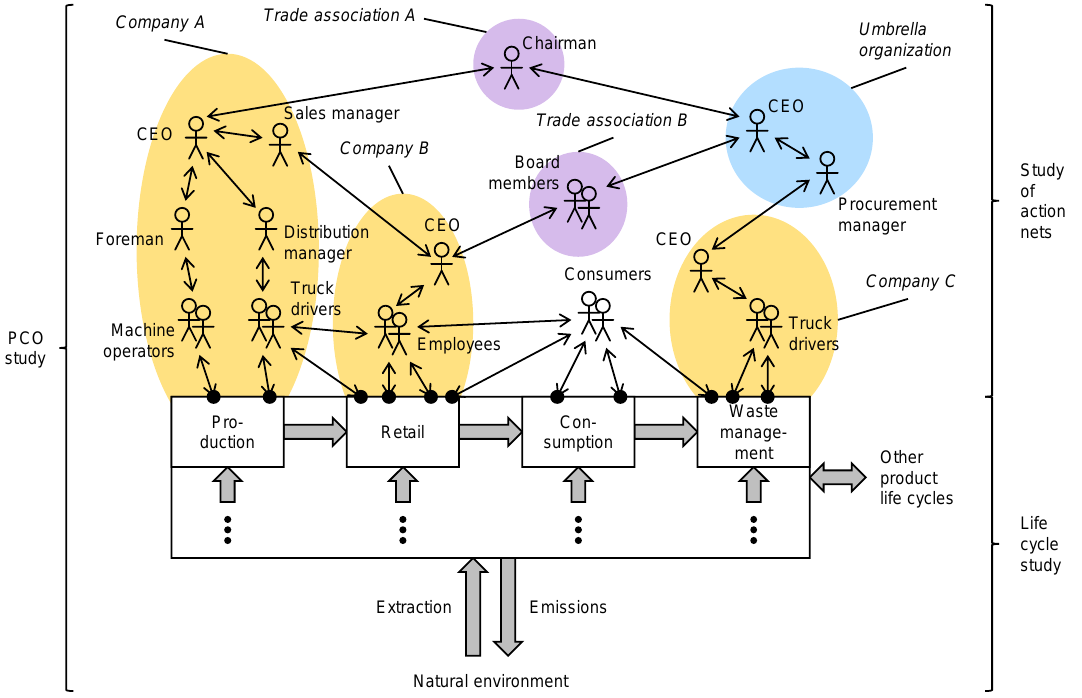
Figure 1. Structure of a hypothetical product chain organization (PCO) study and its results. An environmental life cycle study is related to a study of action nets via socio-material interaction points at the product life cycle (SMIPs) (larger black dots). Boxes represent technical processes, thick arrows represent material flows, vertically consecutive discs represent further material relations, and thin arrows represent human interactions. CEO = chief executive officer.